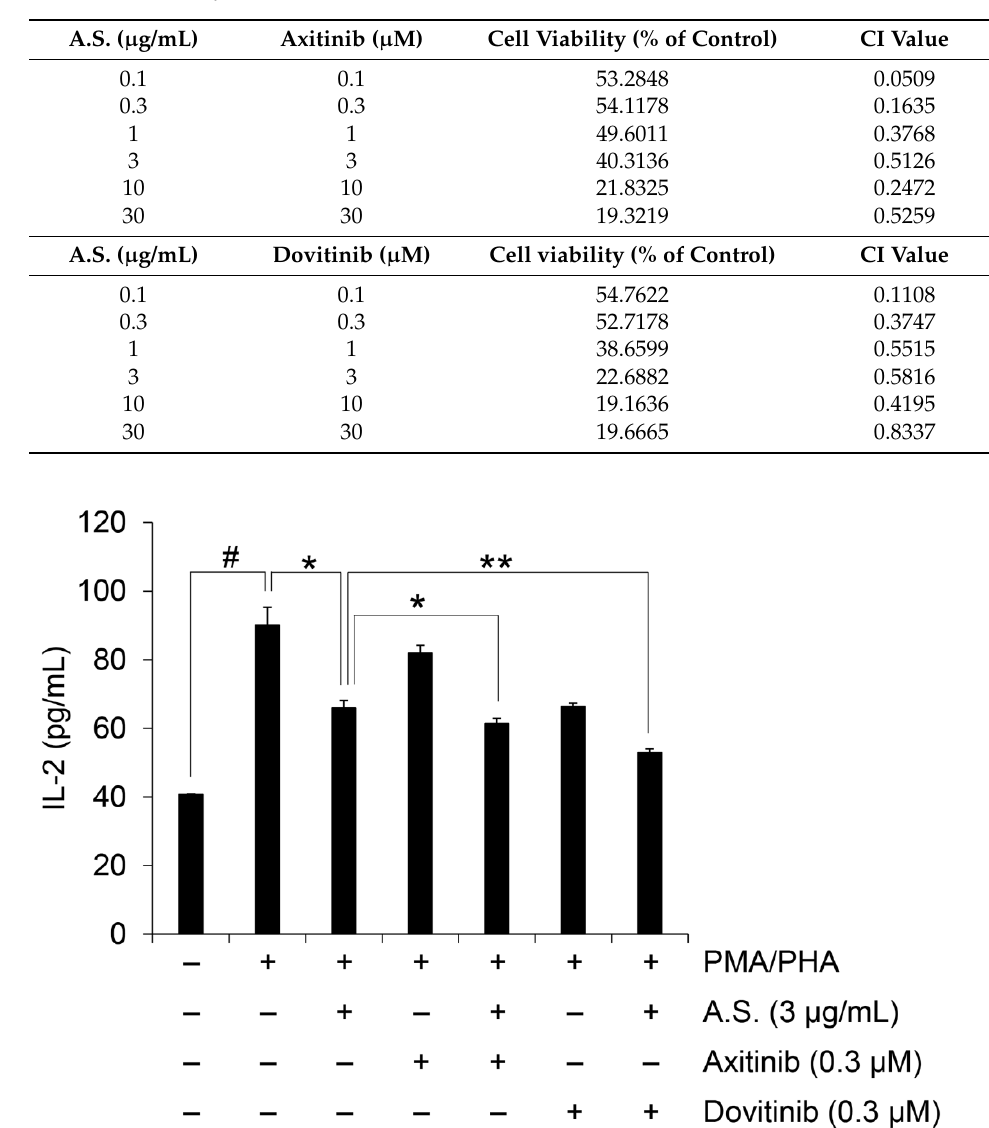
Figure 5. Combination therapy synergistically inhibits IL-2 expression. IL-2 concentration in culture medium of Jurkat cells treated for 24 h with PMA (50 ng/mL) plus PHA (1 µ g/mL) together with A.S. extract, A.S. extract alone or in combination with axitinib or dovitinib. Experiments were performed in triplicate. Data are presented as mean ± SD. * p < 0.01 and ** p < 0.001 (vs. cells treated with PMA/PHA and A.S extract treated group); # p < 0.01 (vs. untreated cells).